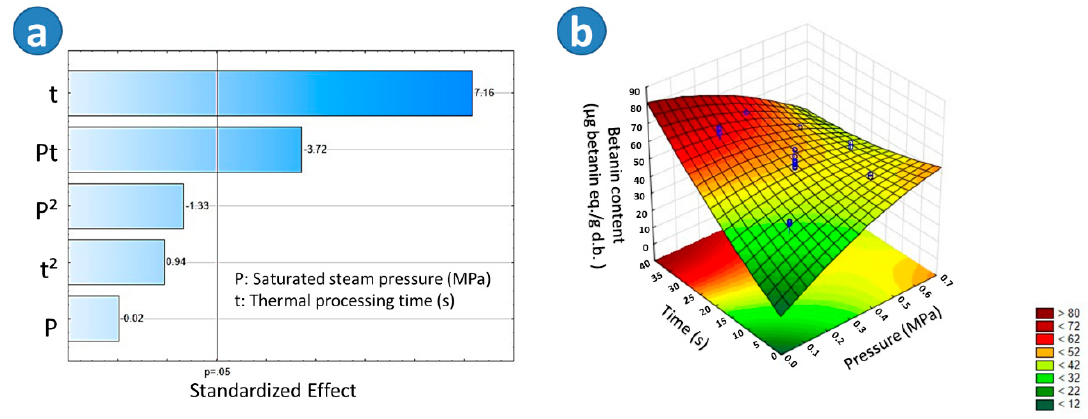
Figure 4. E ff ects of steam pressure “P” (MPa) and thermal processing time “t” (s) on the Betanin Concentration (BC) of Blanched Swell-Dried (BSD) red beetroots. ( a ) The Pareto chart and ( b ) surface response plot are shown.